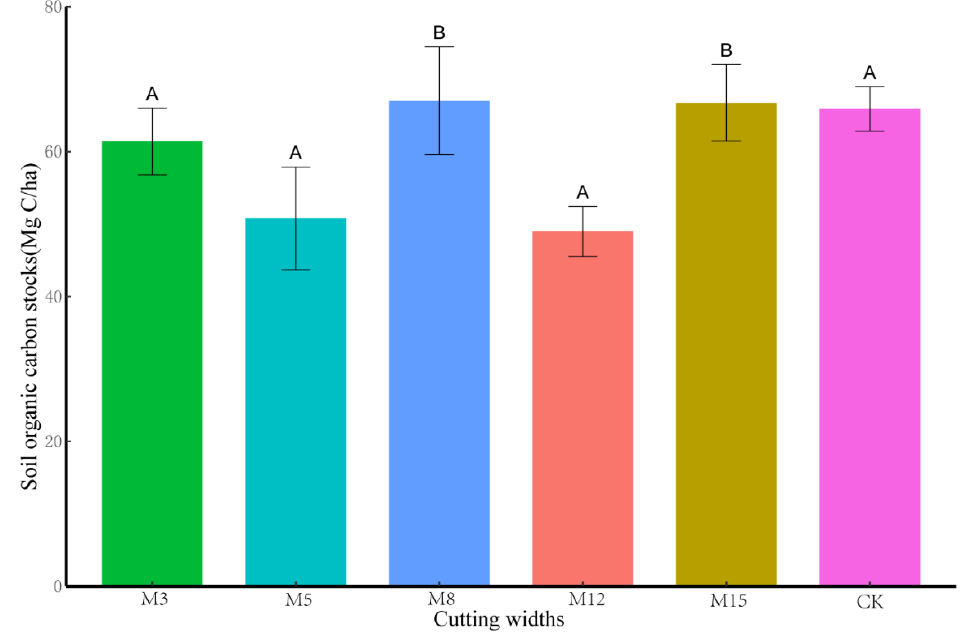
Figure 2. Soil organic carbon content for moso bamboo in strip cutting (M3, M5, M8, M12, and M15) or unharvested (CK) plots. Different uppercase letters (A, B) indicate significant dif-ferences among cutting widths ( p <